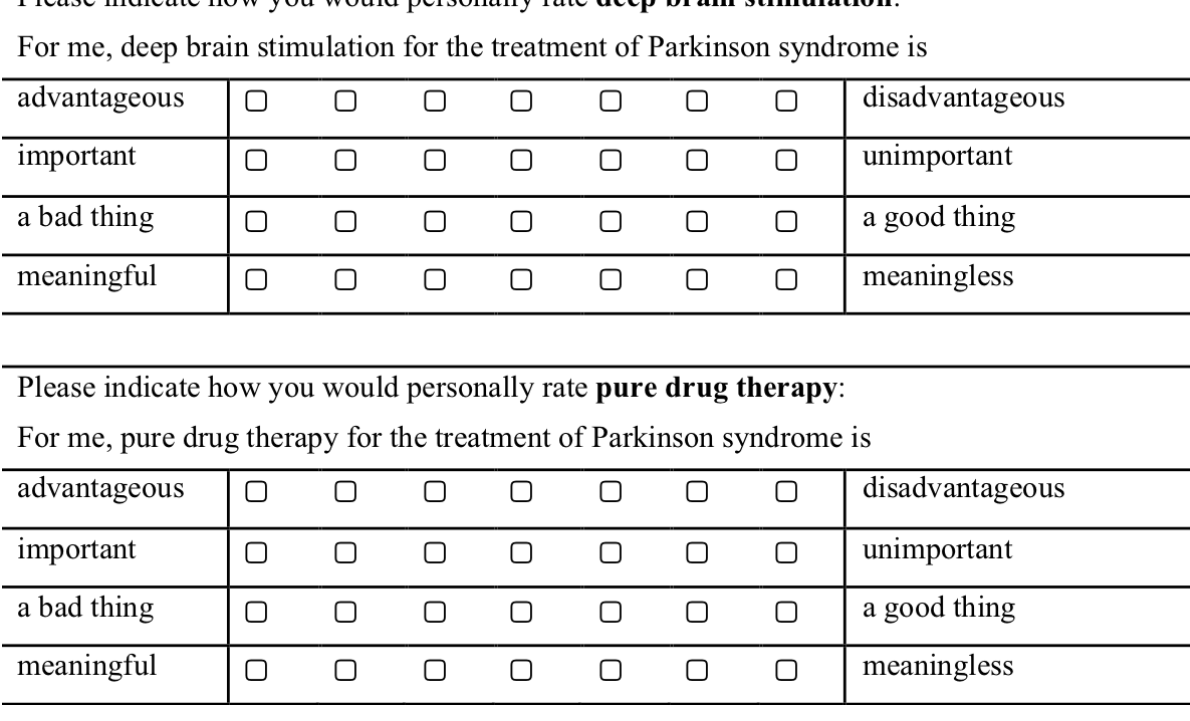
Figure 1. Attitude toward treatment options.